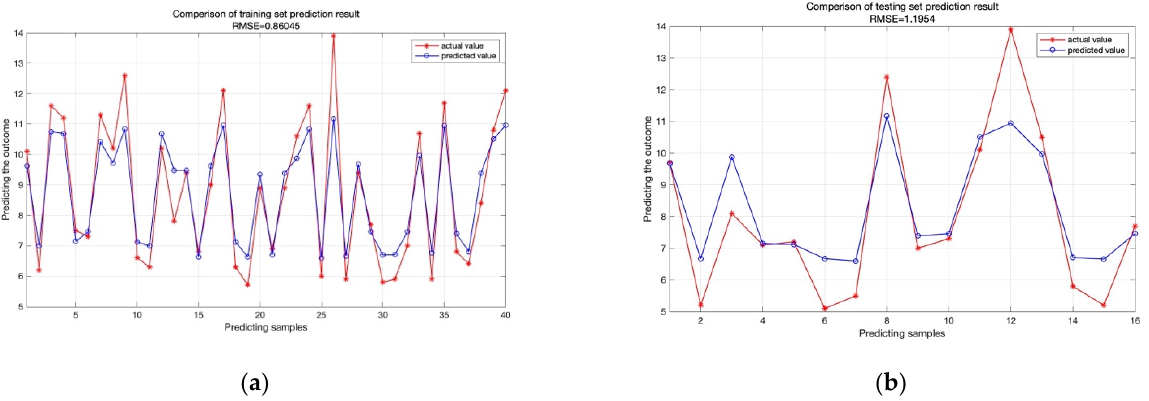
24 of 27 24 of 27